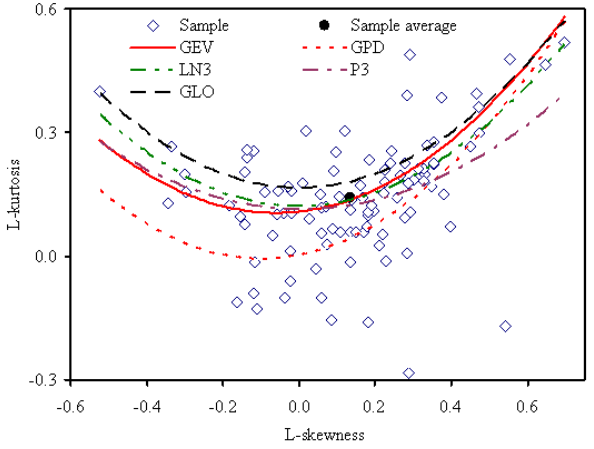
Fig. 6. Regional L -moment ratio diagram of the AMF for the River Nile